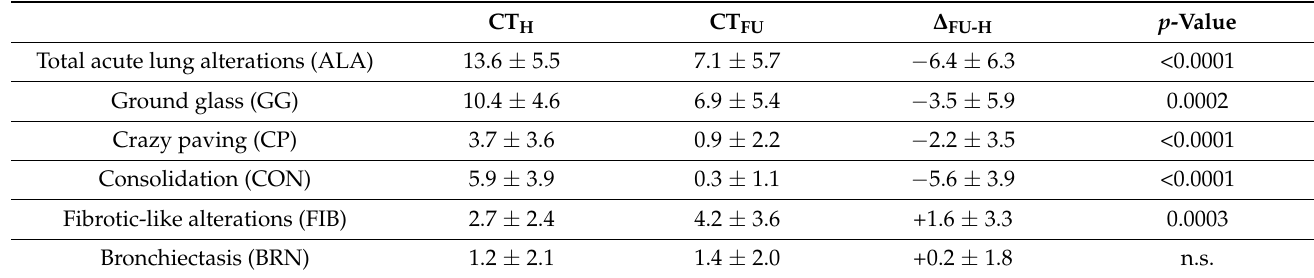
Table 2. CT scan abnormalities during hospitalization (CT H ) and at follow-up (CT FU ).